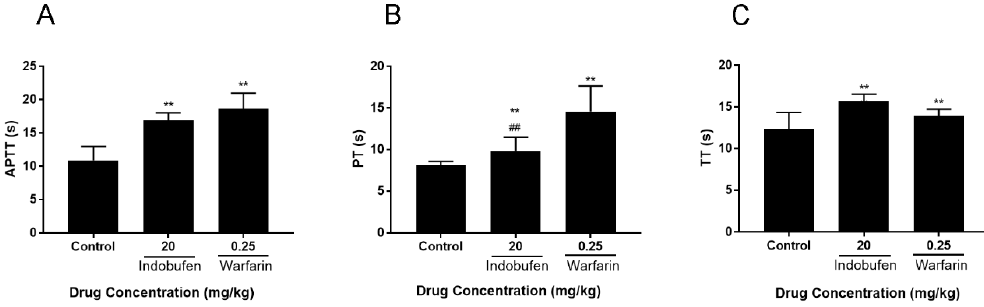
Figure 2. The effects of indobufen on activated partial thromboplastin time (APTT, A ), prothrombin time PT, B ), and thrombin time (TT, C ) in rabbits. ** p < 0.01 versus the control group ## p < 0.01 versus